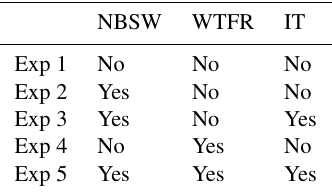
Table 1. Numerical experiment